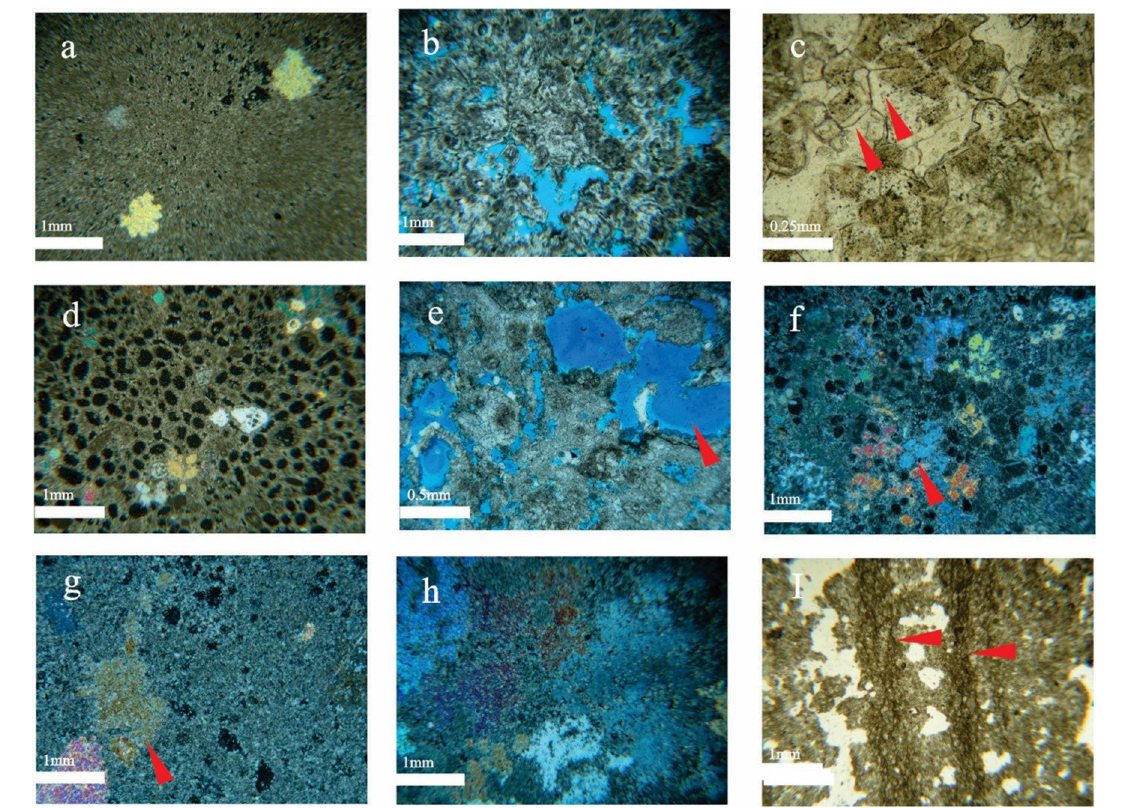
Fig. 6 Diagenetic features in the Arab successions. a Fine-crystal- line dolomites were formed in mud-dominated facies, b medium-to- coarse-crystalline dolomites were formed in grain-dominated facies, c dolomite cementation in grain-dominated facies, d moldic disso-